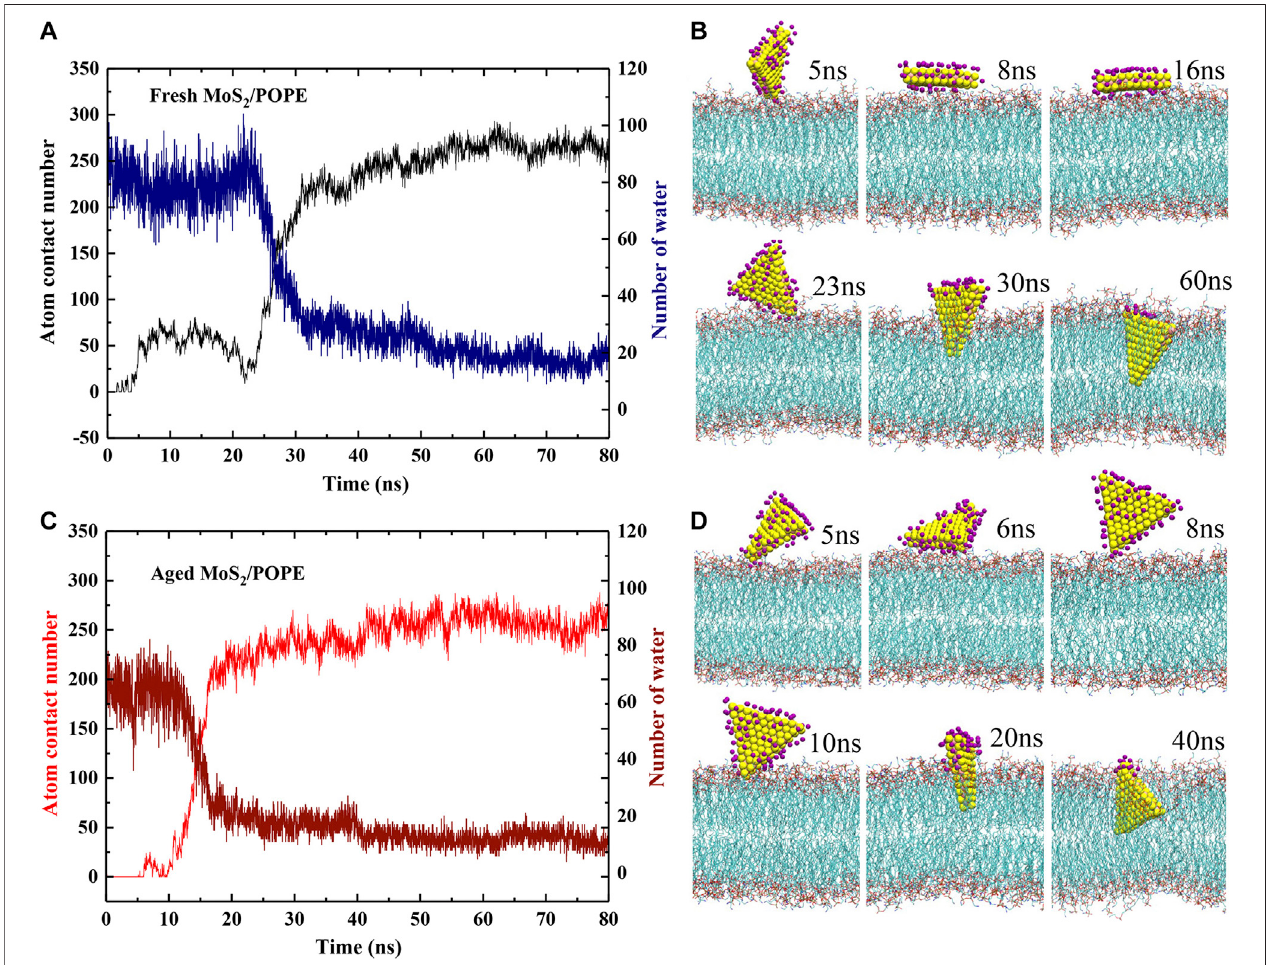
FIGURE 3 | Insertion processes of the MoS 2 nanosheets into the POPE lipid membrane. (A, C) The time-dependent atom contact numbers and surface water molecules for the (A) fresh and (C) aged MoS 2 nanosheets. (B, D) The typical conformations of the (B) fresh and (D) aged MoS 2 nanosheets during the insertion processes. The dark purple spheres represent the water oxygen